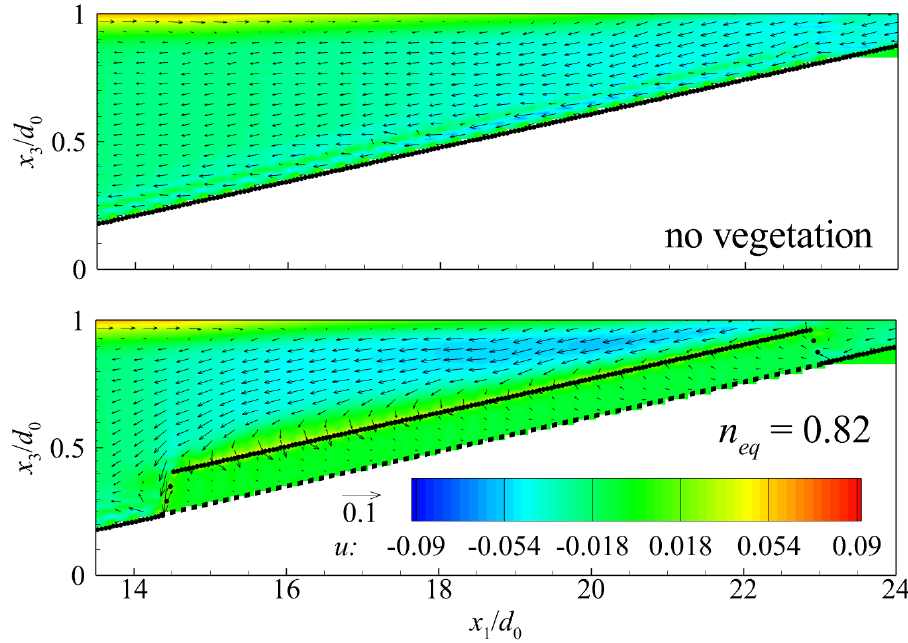
Figure 10. Period ‐ mean 2DV velocity field (Case 1 on top and Case 5 on bottom). Note that the axes are in scale x 1 / x 3 = 0.3 for clarity of the exposition. The dotted black line indicates the CV area. Finally, the period ‐ mean free ‐ surface level for all cases was computed (Figure 11).